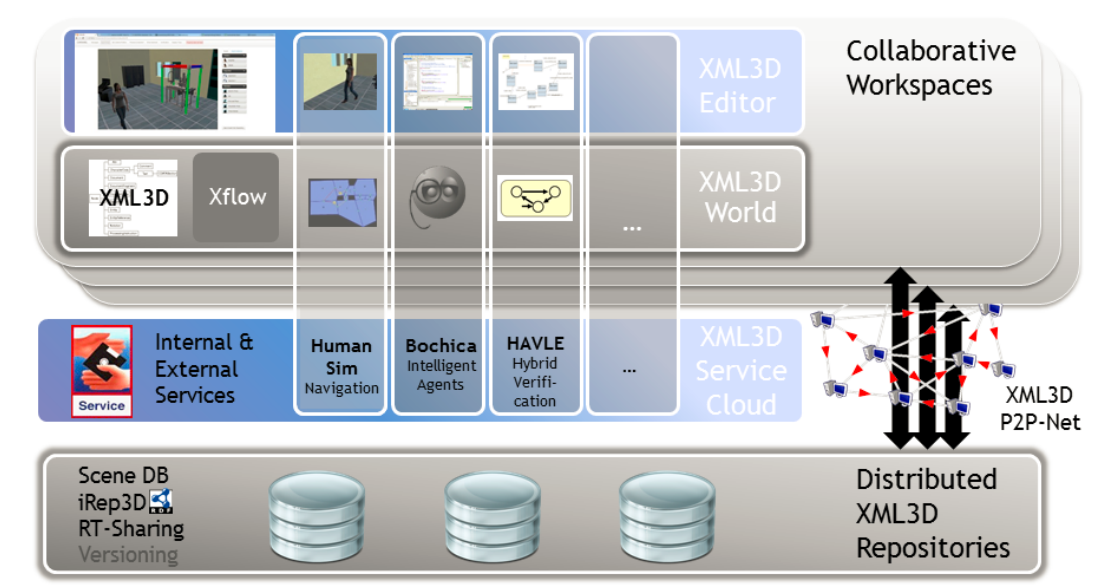
Figure 2. Collaborate 3D